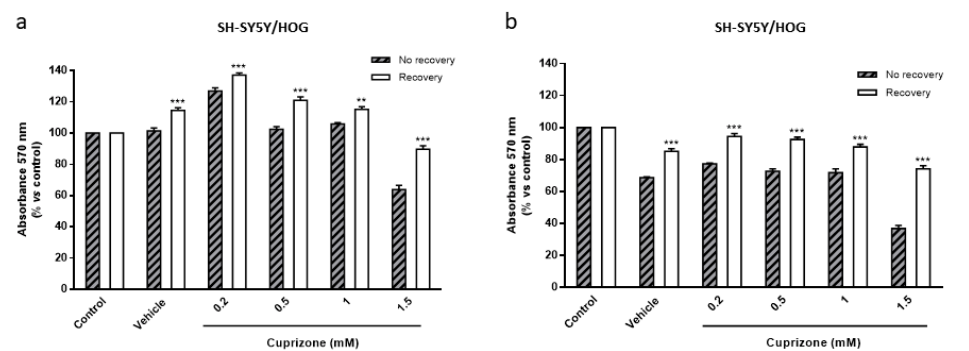
Figure 7. MTT reduction assay in SH-SY5Y/HOG co-cultures treated with increasing concentra- tions of CPZ (0.2–1.5 mM) for 24 h followed by 24 ( a ) or 48 h ( b ) without the treatment (recovery period). Cell damage is represented as the percentage of MTT reduction versus control. Data are the mean ± S.E.M of five independent experiments. Significant differences were analyzed by a two-way ANOVA followed by post-hoc Tukey’s test. ** p < 0.01, *** p < 0.001 compared to no recov- ery.